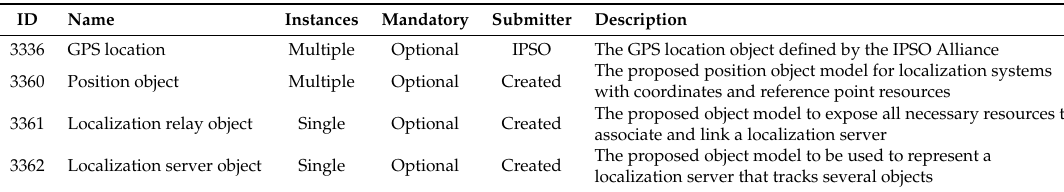
Table 1. LwM2M/IPSO objects related to location data.